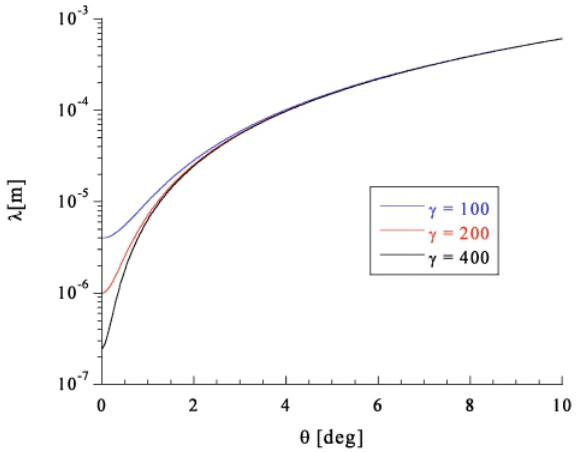
FIG. 1. (Color) Fundamental wavelength as a function of angle of observation for various electron